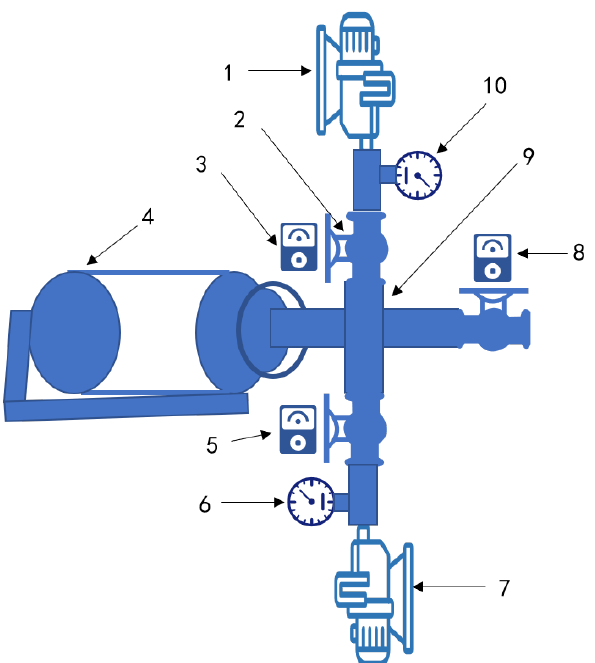
Figure 1. Schematic diagram of the pulsed pressure curing equipment. (1. Booster pump; 2. Electric two-way valve; 3. Positive pressure control module; 4. Pickling container; 5. Negative pressure control module; 6. Negative pressure control table; 7. Vacuum pump; 8. Atmospheric control module; 9. Four-way valve; 10. Positive pressure control table.).